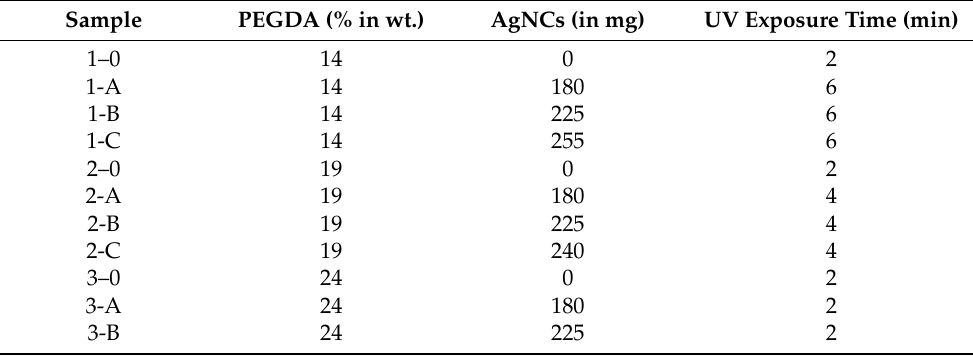
Table 1. Composition of the investigated samples and the UV exposure time. Sample PEGDA (% in wt.) AgNCs (in mg) UV Exposure Time